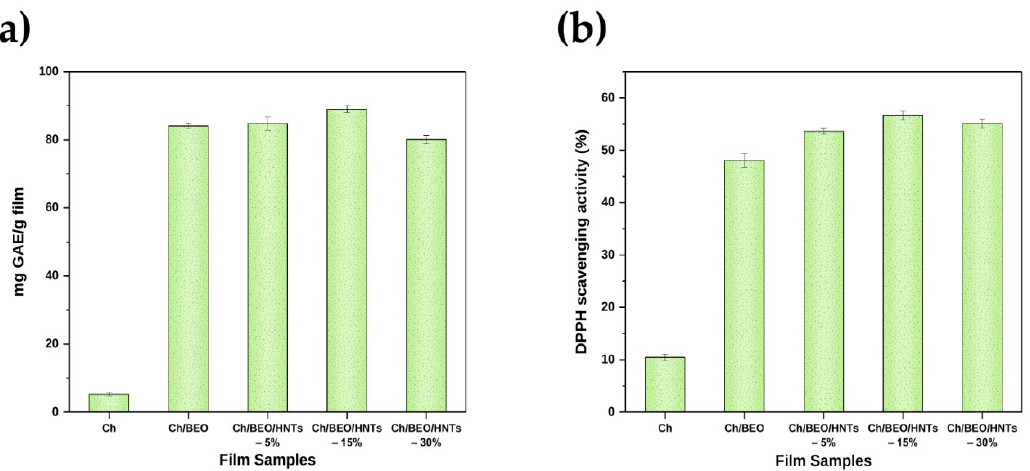
Figure 8. Antioxidant activity of Ch films formulated with HNTs and BEO. ( a ) Total phenolic content; ( b ) DPPH scavenging